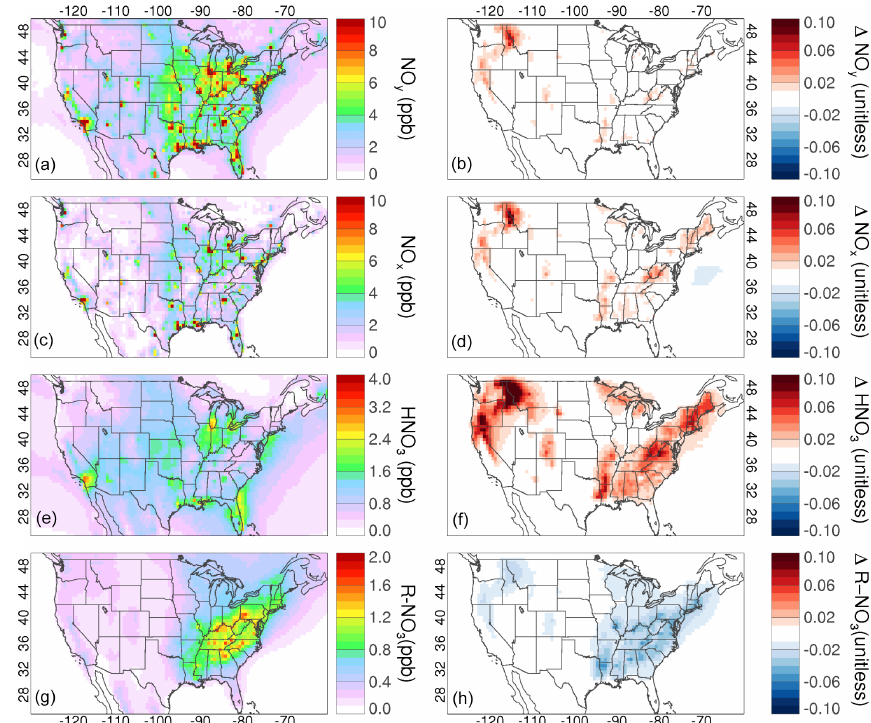
Figure 8. Left: mean JJA mixing ratios of reactive nitrogen oxides in the base scenario (Simulation 1). Right: the relative changes as a result of predicted tree mortality (Simulation 4 – Simulation 1). (a, b) Total NO y ; (c, d) NO x ; (e, f) HNO 3 ; and (g, h) the sum of all alkyl-, peroxy-, and